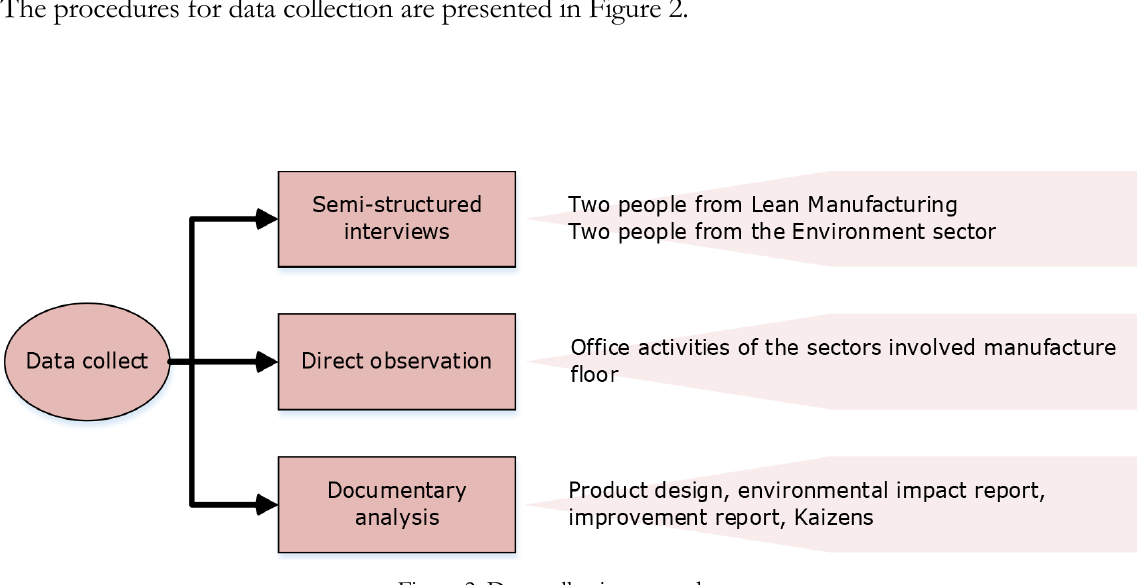
Figure 2. Data collection